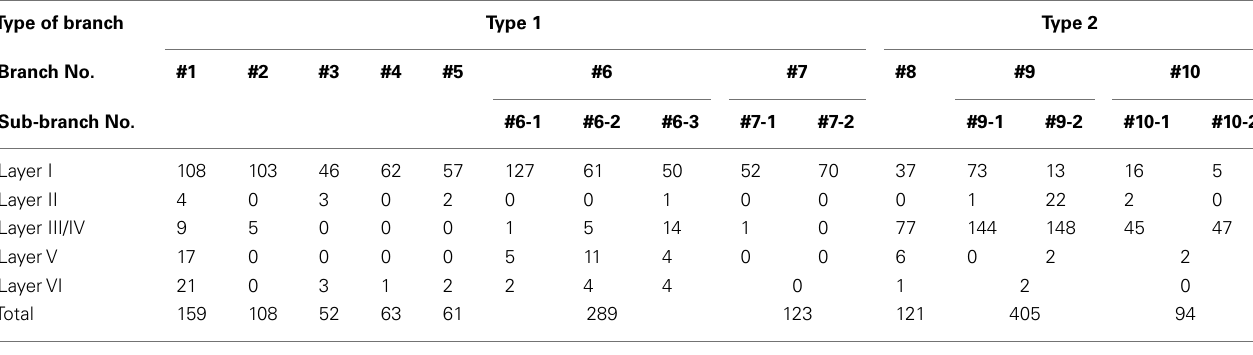
viral vector in in vivo (Miyashita et al., 2010; Zgraggen et al., 2011). The existence of type 1 and 2 branches may guide the way to solve a discrepancy related to the target layer of AV terminals. One group of studies has emphasized that layer Ia is almost the sole tar- get of AV terminals (Van Groen and Wyss, 1995); the other group has shown AV terminals in both layers Ia and III/IV (Shibata, 1993). This discrepancy may be derived from a tracer injection falling in a segregated mass of different types of neurons within the all animals, type 2 branches were only found in rats 1 and 2, which III/IV. Van Groen and Wyss (1995) may have injected tracers into the AV, where type 1 neurons aggregated, but, Shibata (1993) may have injected tracers into the area, where both type 1 and 2 neu- rons existed. In consistent with this idea, our results showed that different position of BDA injection within AV resulted in either dense terminals in layer Ia with weak labeling in layer III/IV or equal density in layer Ia and III/IV (this study). Another possibil- ity is that potential preferential uptake of the different tracer (i.e., tracer, PHA-L, Shibata, 1993; tracer, Fluoro-Ruby, Van Groen and Wyss, 1995) by type 2 and/or type 1 branches, respectively. Recent methods for more clearly visible single labeling of small number of neurons (Deschênes et al., 1996; Kuramoto et al., 2009) can give more concrete answer for the hypothesis